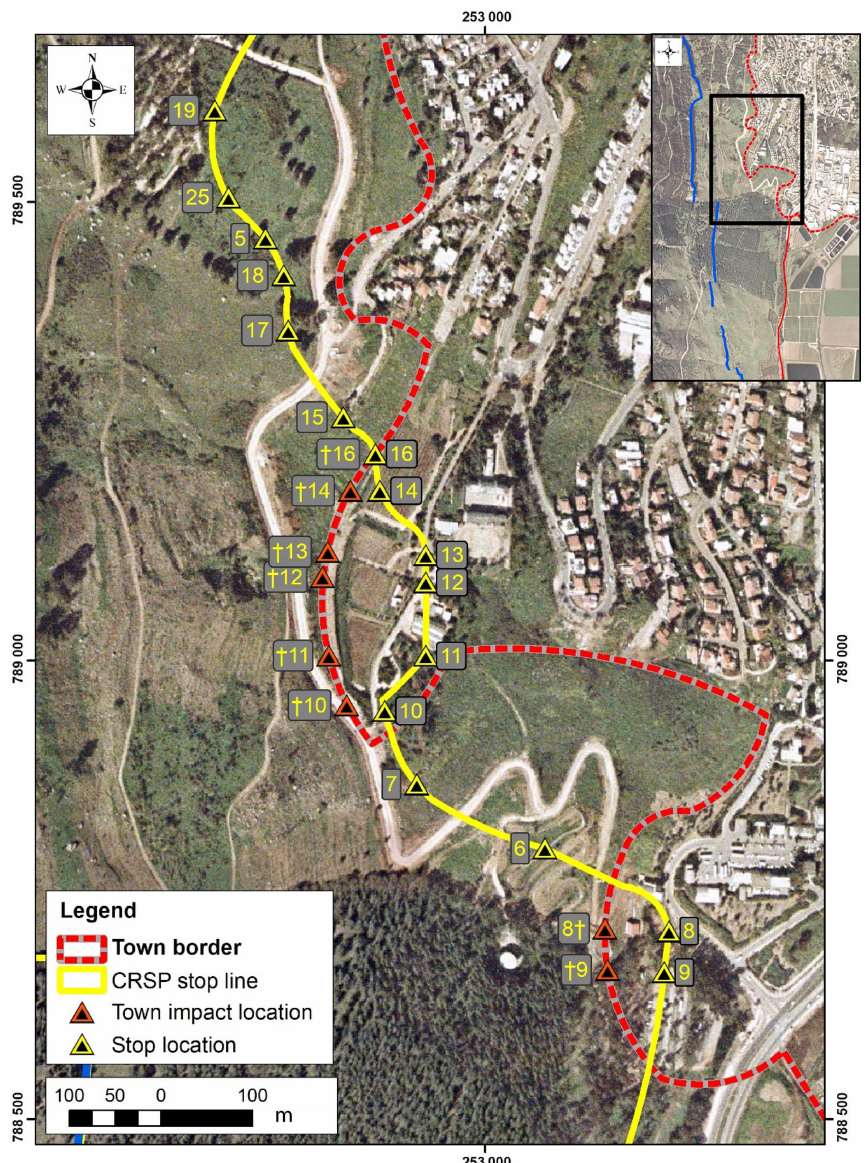
Figure 9. Rockfall hazard map for the town of Qiryat Shemona. The yellow line represents the CRSP 100% stop line calculated for large blocks ( D is 5.8 and 6.2m). Yellow–black hazard triangles mark the simulated stop line and location for each profile. Orange–black hazard triangles mark the simulated town border impact location for each profile; profile numbers in yellow refer to simulated profile numbers; indices with the sword label “†” mark locations of rockfall impact at the town border. Map location is shown in the